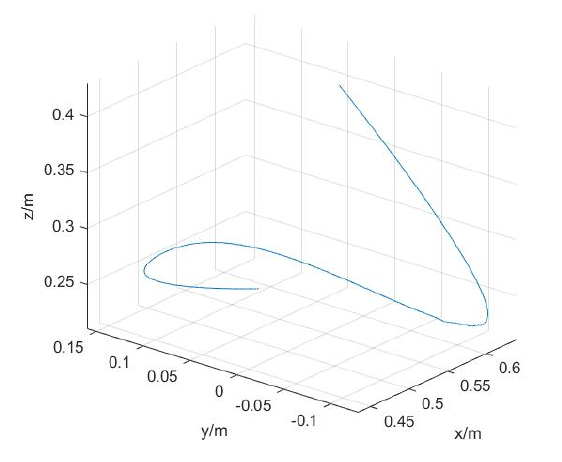
Figure 5. Test trajectories in Cartesian